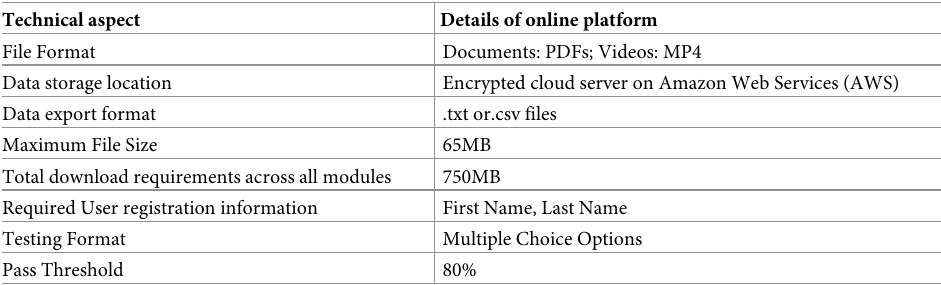
Table 2. Overview of the technical specification of the online platform.